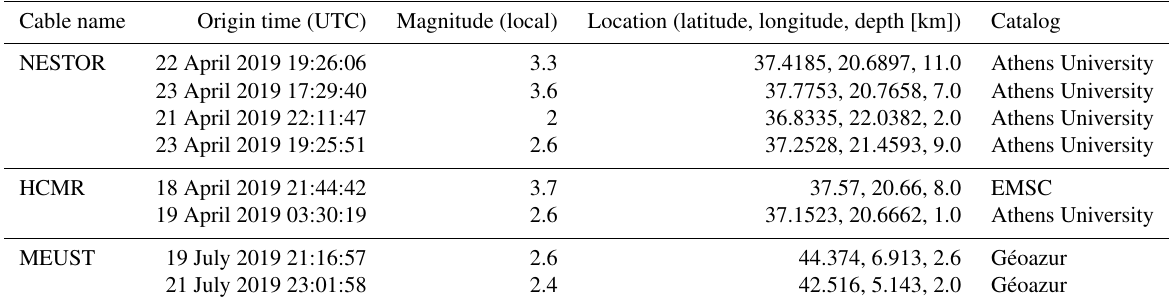
Table 1. Earthquakes used in this